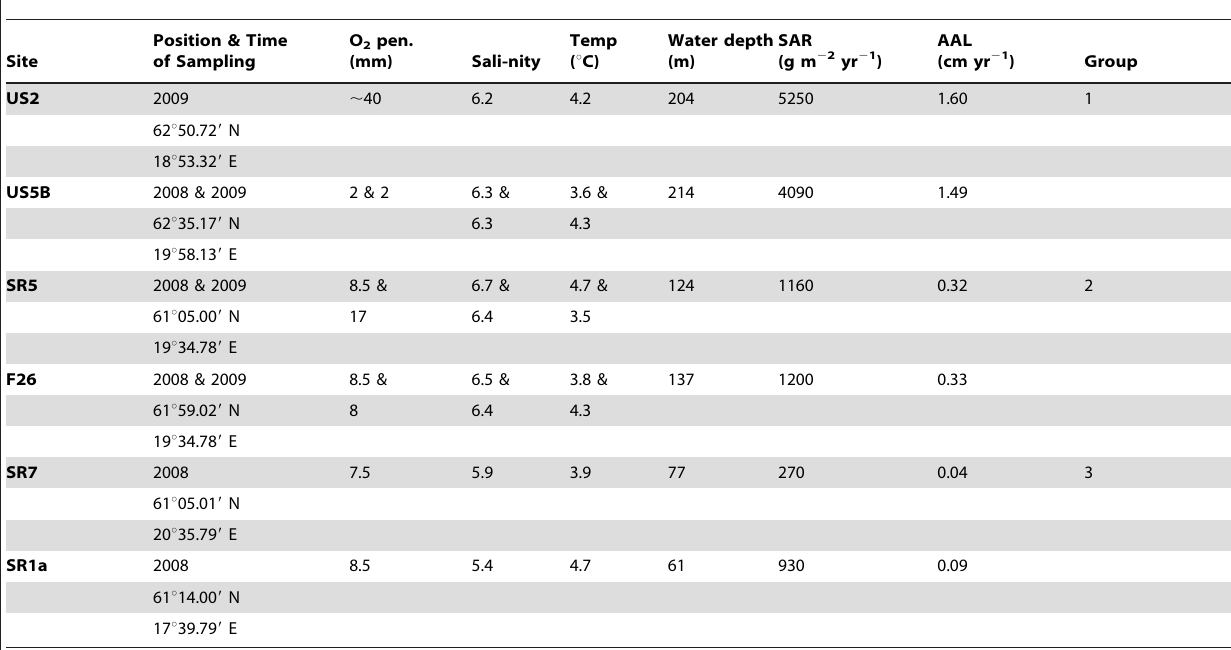
Table 1. Characteristics of the 6 study sites based on conditions at the time of sampling in October 2008 and June 2009.